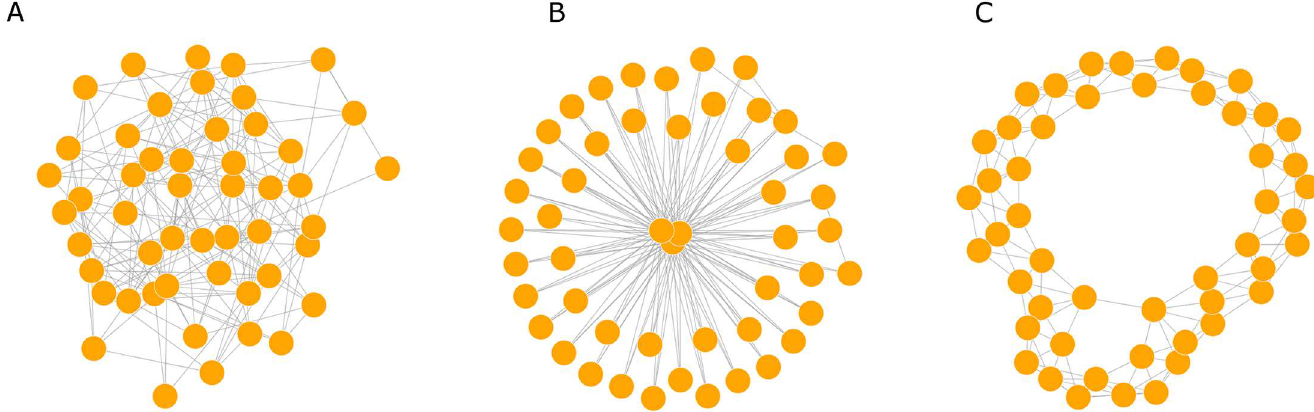
Fig 1. Prototypic network structures. A. Erd ő s-Re´nyi network (ER), B. Baraba´si-Albert network (BA), C. Watts-Strogatz network (WS). To illustrate the typical configurations, all networkshave the same size (50 nodes) and they are characterized by the same mean degree(6). The rewiringprobabilityis 0.01 in